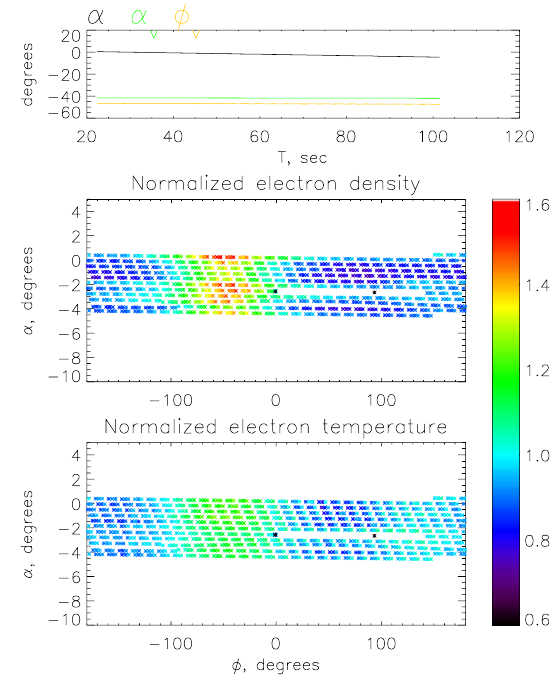
Fig. 15. Map of plasma parameters in (φ,α) coordinates for Case 3. The format is the same as in Fig.